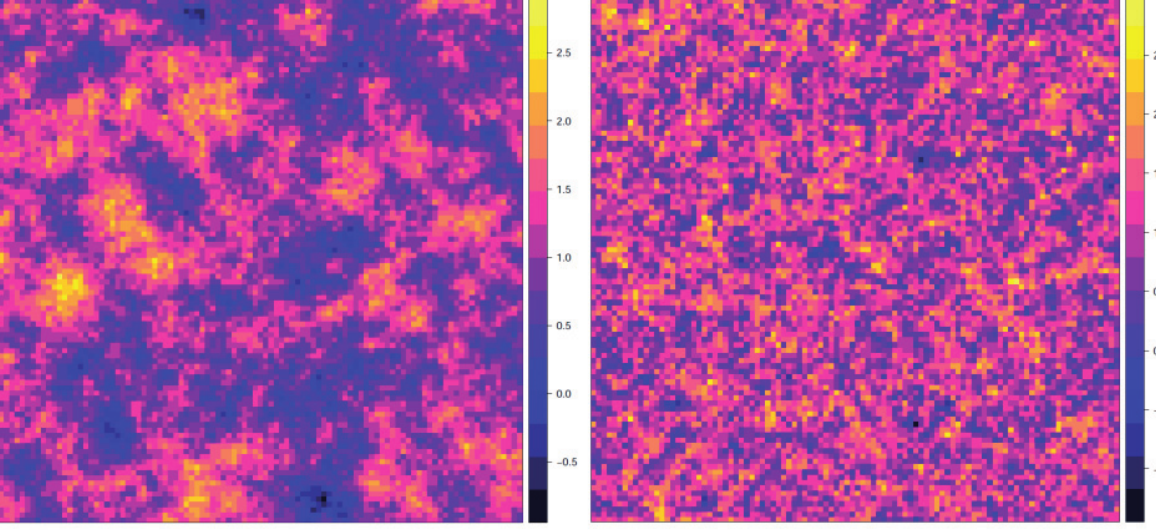
Figure 2. Simulated spatial distribution of (physical) vulnerability with two different levels of spatial autocorrelation, gemerated by sto- chastic realization of Gaussian Random Fields. The distribution on the left side has a higher coefficient of spatial correlation with respect to the distribution on the right